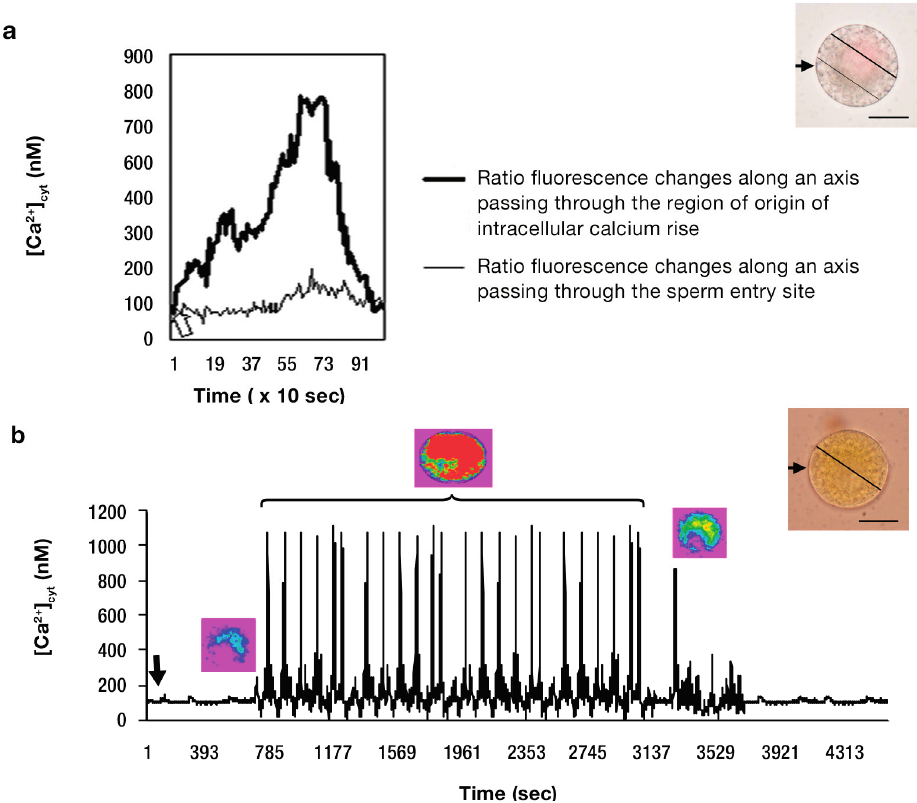
Figure 3. The 340/380 nm excitation ratios of fura-2 dextran-injected wheat egg cells showing [Ca 2+ ] cyt variations in response to the different maturational stages of the batch of the egg cells used for in vitro fertilization. ( a ) Typical, fertilization-associated [Ca 2+ ] cyt rise in an in vitro fertilized wheat egg cell developed in situ and isolated three DAE (the arrow denotes 10 min after in vitro fertilization (IVF)). The bright field image (inset) at the right upper corner shows the lines (axes) of pixels along which the pixel intensities ( i.e ., the changes in calcium concentrations) were measured through the active dimension, time; the arrow shows the site of sperm incorporation, and the bar represents: 15 µm; ( b ) Representative [Ca 2+ ] cyt changes occurring concomitantly upon in vitro fertilization of mature wheat egg cells (isolated at six DAE). This dynamics of the [Ca 2+ ] cyt change could be seen in 66 out of 80 (81.5%) egg cells fertilized with the sperm (the arrow indicates the time at which fusion between the sperm and the egg cell occurred). The [Ca 2+ ] cyt peak elicited by the sperm ensued 10 min after the in vitro fusion of the gametes of opposite sexes. The pseudo-colored images (insets) give a visual representation of the change in [Ca 2+ ] cyt , whereas the bright-field image shows the axis along which the pixel intensities ( i.e ., the changes in calcium concentrations) were measured. The arrow shows the site of sperm entry, and the bar represents: 20 µm; ( c ) A slow [Ca 2+ ] cyt rise induced by sperm cell fusion in an overmature egg cell isolated 11 DAE (the arrow shows the time lapse, 17 min, between sperm–egg fusion and the commencement of the slow [Ca 2+ ] cyt elevation). The bright-field image at the right upper corner shows the axis along which the pixel intensities ( i.e ., the changes in calcium concentrations) were measured. The arrow shows the site of sperm entry, and the bar represents: 25